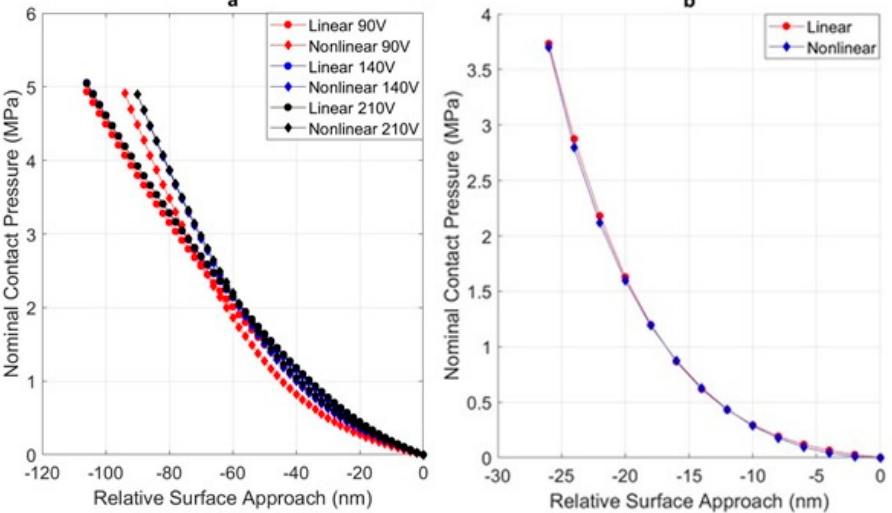
Figure 10. Pressure-relative surface approach derived from linear and nonlinear interfacial stiffness: ( a ) experimental data of the current study at incidents amplitude excitations of 90 V, 140 V and 210 V; ( b ) experimental data from [22] at incidents amplitude excitations of 374 V .